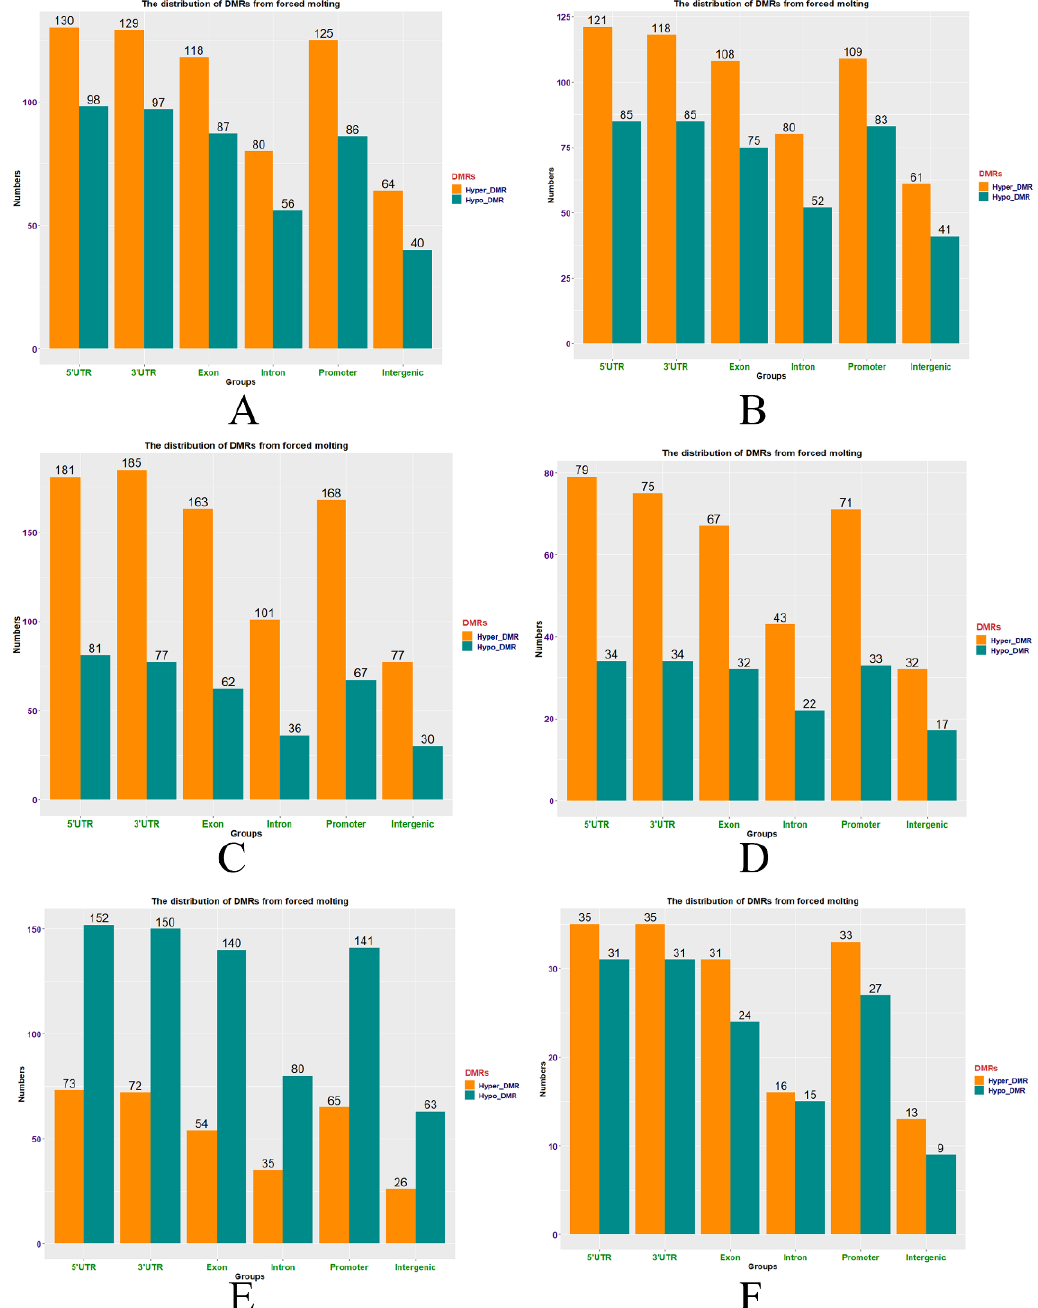
Figure 2. Distribution of DMRs in various genomic elements at different sequence contexts. The horizontal coordinate is the functional region of genes; the vertical coordinate is the corresponding number of DMRs; the colors represent different methylation states. Six figures represent the distri- bution of DMRs in the hypothalamus ( A ) and ovary ( B ) from 1-vs.-2, hypothalamus ( C ) and ovary ( D ) from 2-vs.-3, hypothalamus ( E ) and ovary ( F ) from 3-vs.-5.